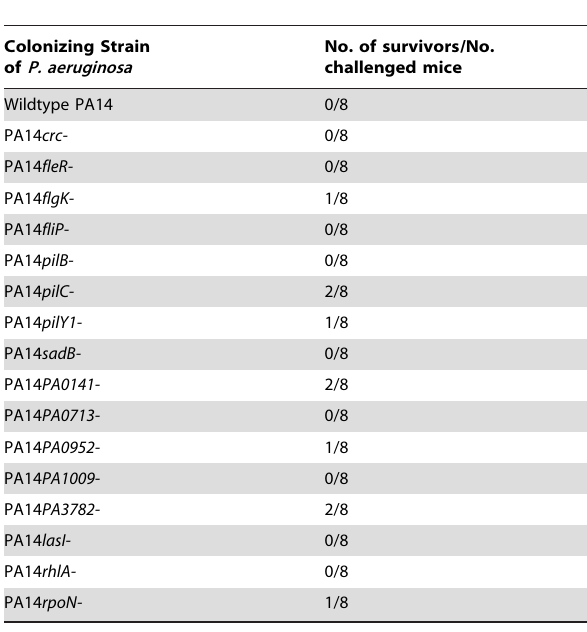
Table 3. Survival of neutropenic mice after administration of 0.2 mg RB6-8C5 MAb